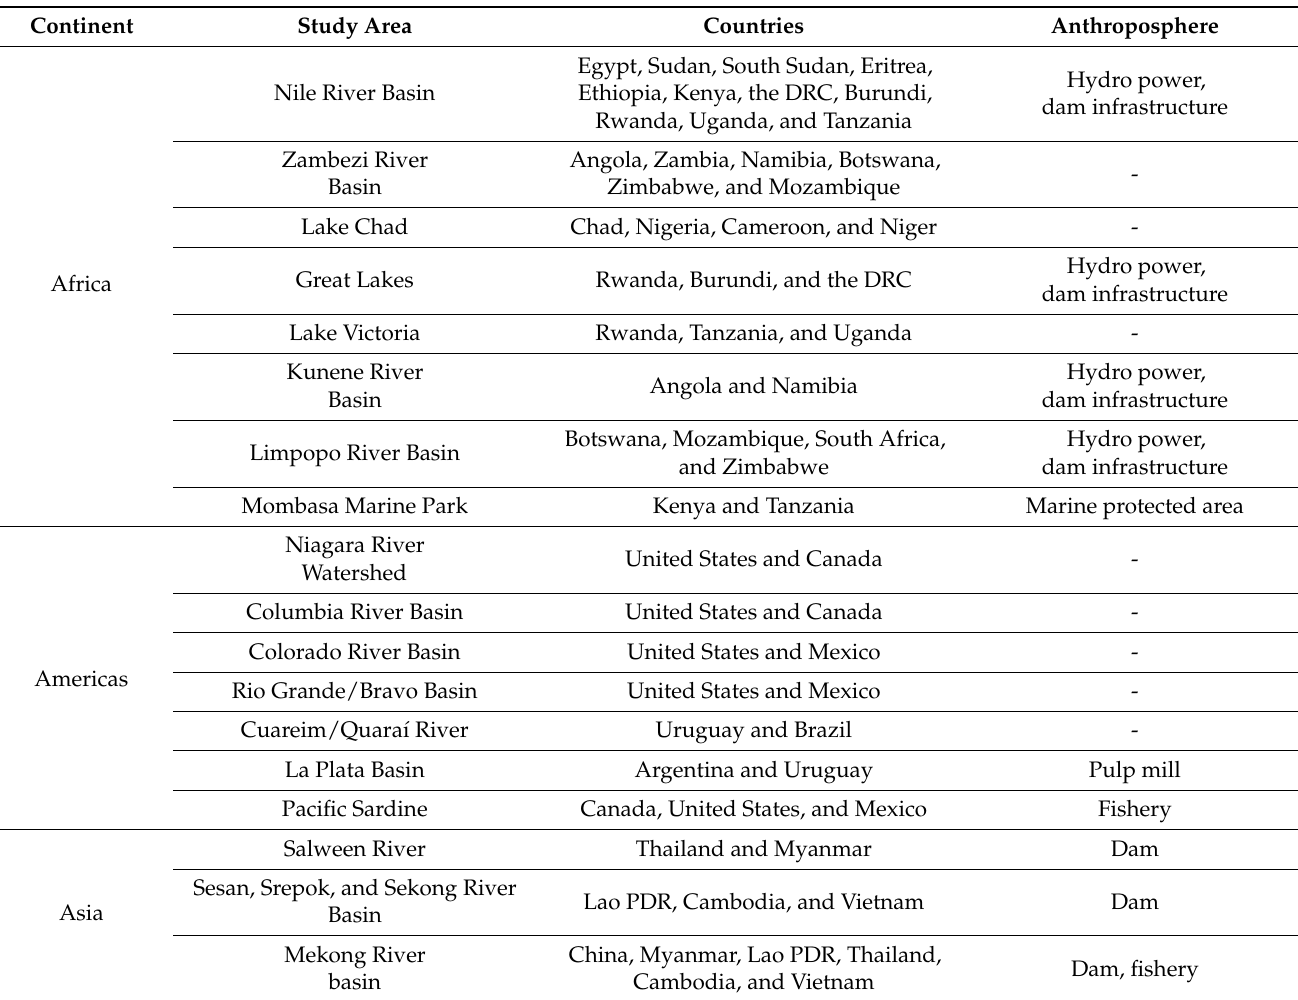
Table 6. The natural resource conflict cases related to the